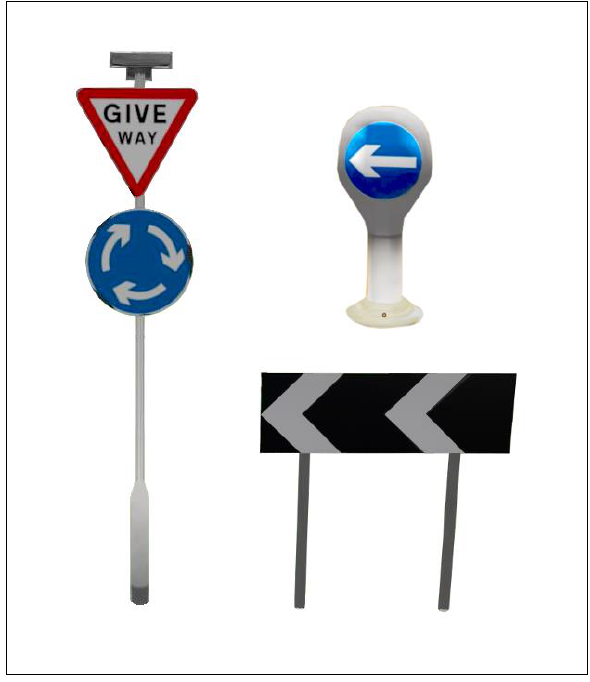
Figure 2. Examples of features in the 3D model. A road sign, a bollard and a sign indicating a sharp deviation to the